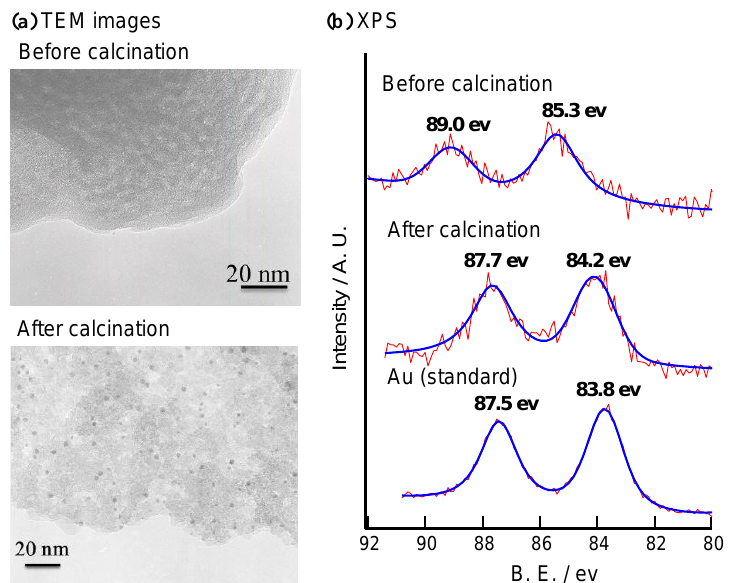
Figure 7. Comparison between the before and after calcined Au/Ti(0.5)-SBA SH (8): ( a ) TEM images, ( b ) XPS data. The calcination was done at 673 K for 2 h.